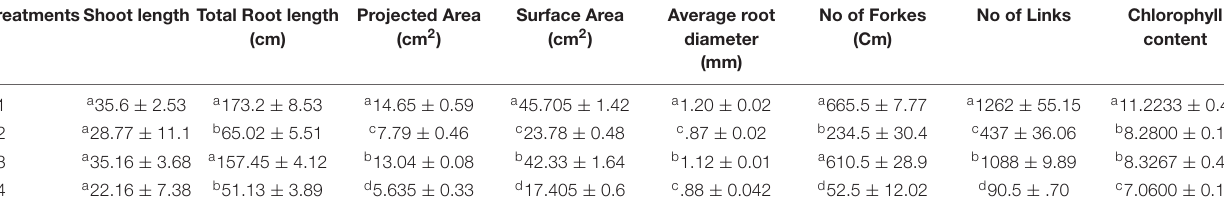
TABLE 8 | Effect of E. profundum PHM11 inoculation on plant growth promotion and physiological attributes of maize. TreatmentsShoot length Total Root length